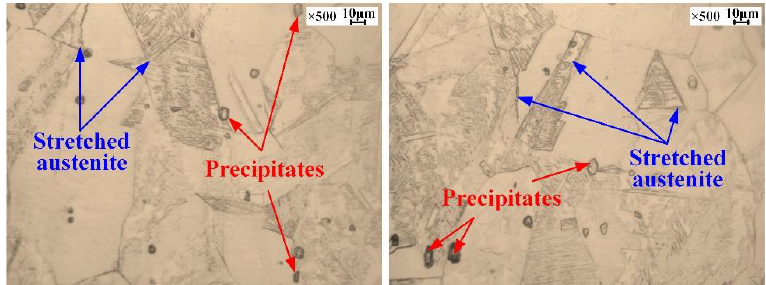
Figure 17. SEM images of patch tubes after different processes. Figure 18. Optical microscope images of the patch tube after hydroforming.